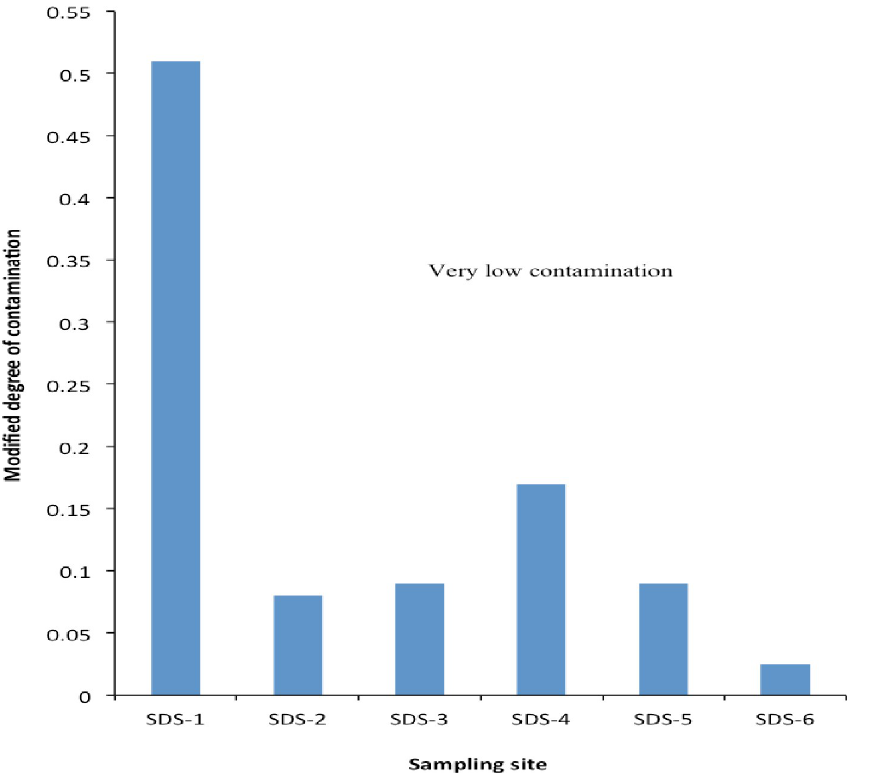
Fig 2. Modified degree of contamination of heavy metals in MSW dumpsite impacted sediment.